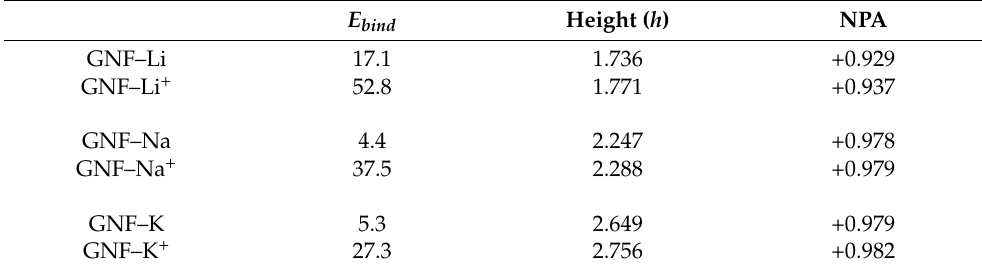
Table 1. The binding energies of M (or M + ) to GNF ( E bind in kcal/mol, M = Li, Na, and K), heights of M from the GNF surface ( h in Å), and NPA-determined atomic charges for M on GNF, calculated at the CAM-B3LYP/6-311G(d,p)